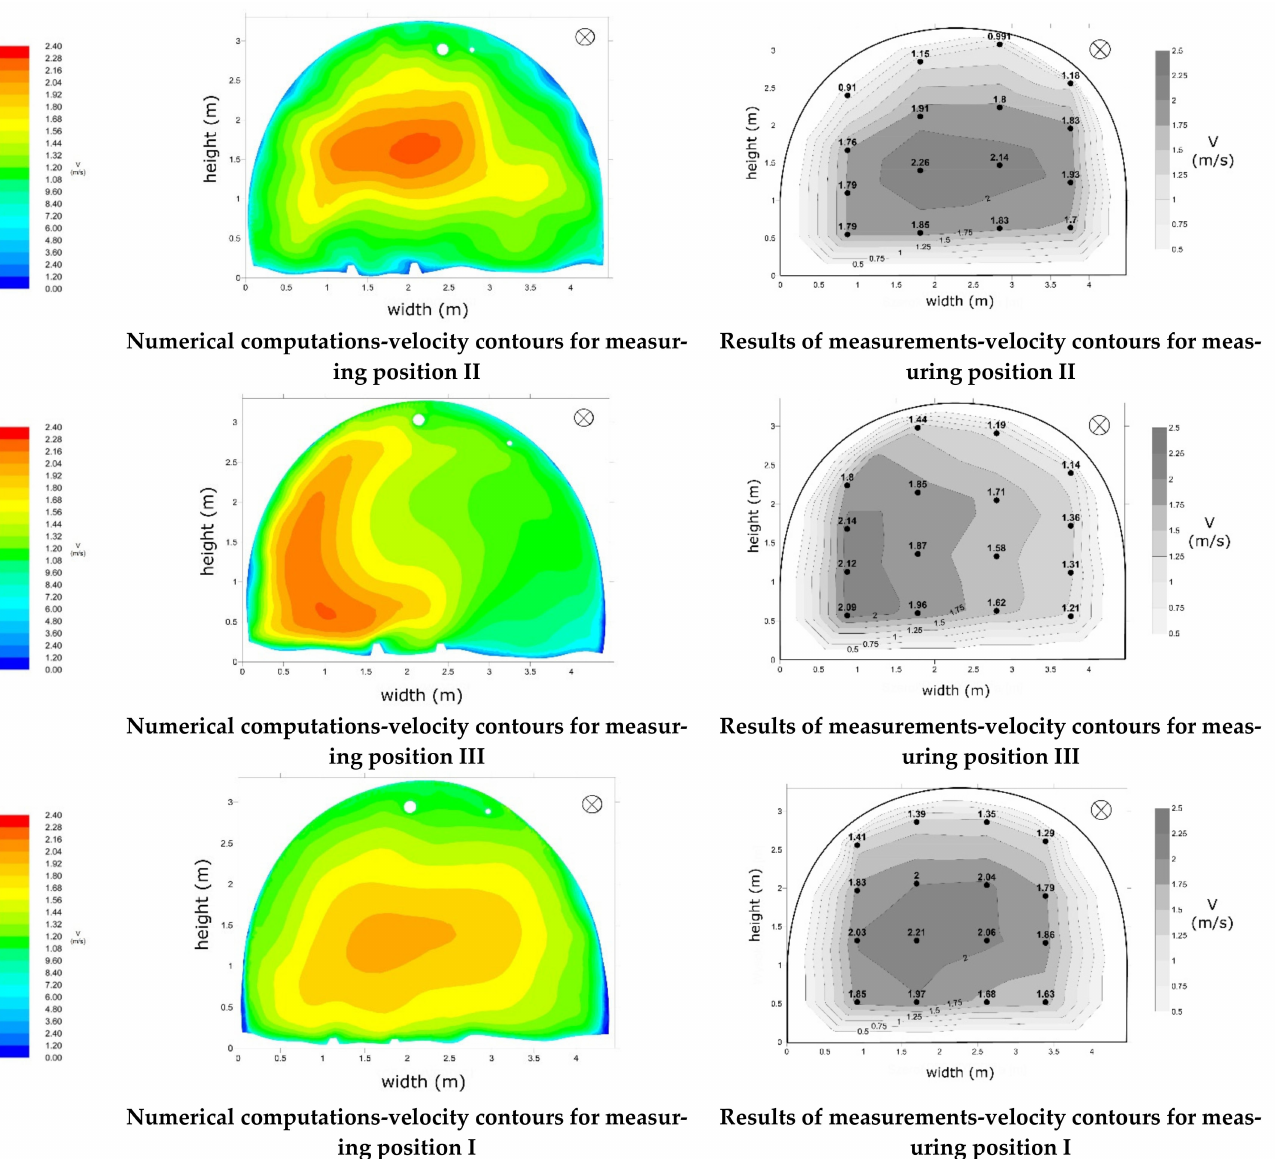
Figure 11. Comparison of numerical computations with the results of measurements for three measuring